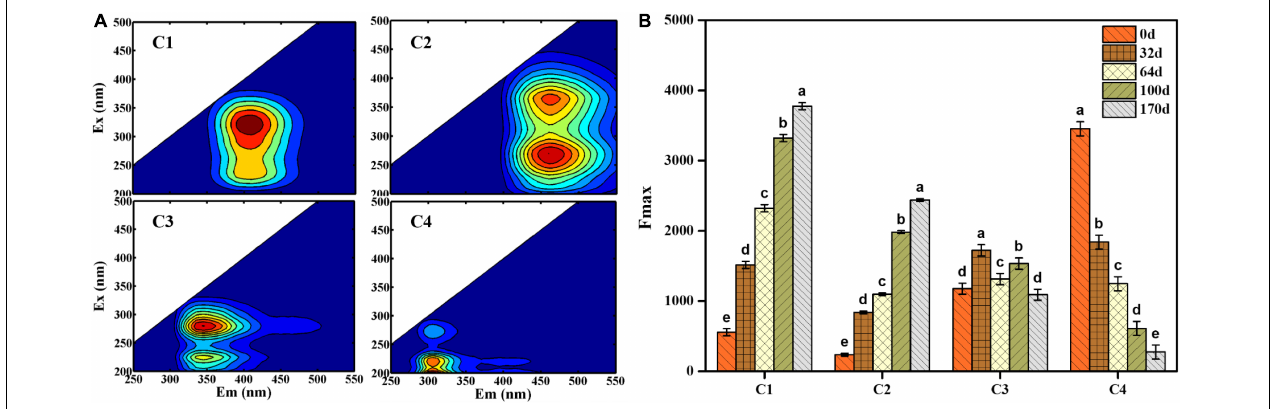
FIGURE 3 | (A) Four fluorescence components obtained by excitation-emission matrix fluorescence combined with parallel factor analysis. (B) The maximum fluorescence intensity (Fmax) of four fluorescence components identified by parallel factor analysis. Histograms that do not share a letter are significantly different ( p <